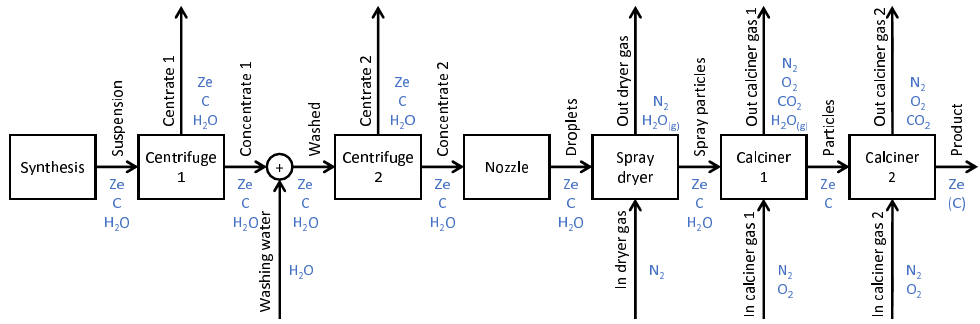
Figure 1. Flowsheet of a zeolite catalyst production process with the corresponding compositions of the material